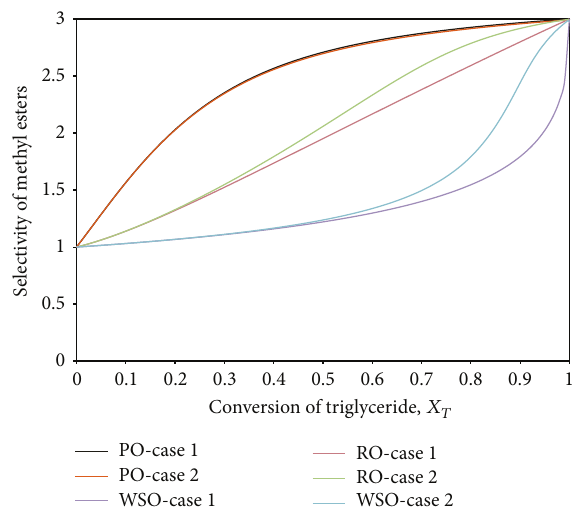
Figure 11: Selectivity plots of methyl ester from various feedstock for Cases 1 and